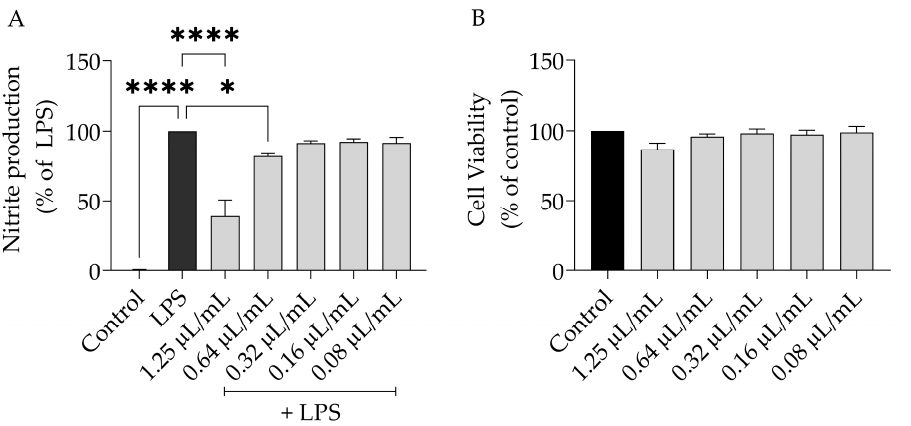
Figure 1. Effect of S. aurea EO on nitrite production. In ( A ), the tests were performed on LPS-stimulated macrophages (measurement after 1 h of pre-treatment with EO and subsequently 24 h of stimulation with LPS). ( B ) Represents the cell viability after 24 h of EO treatment. Results show the mean ± SEM. Statistical significance (* p < 0.05, **** p < 0.0001) was determined by either LPS or control comparison, through one-way ANOVA and consequent Dunnett’s multiple comparison test.